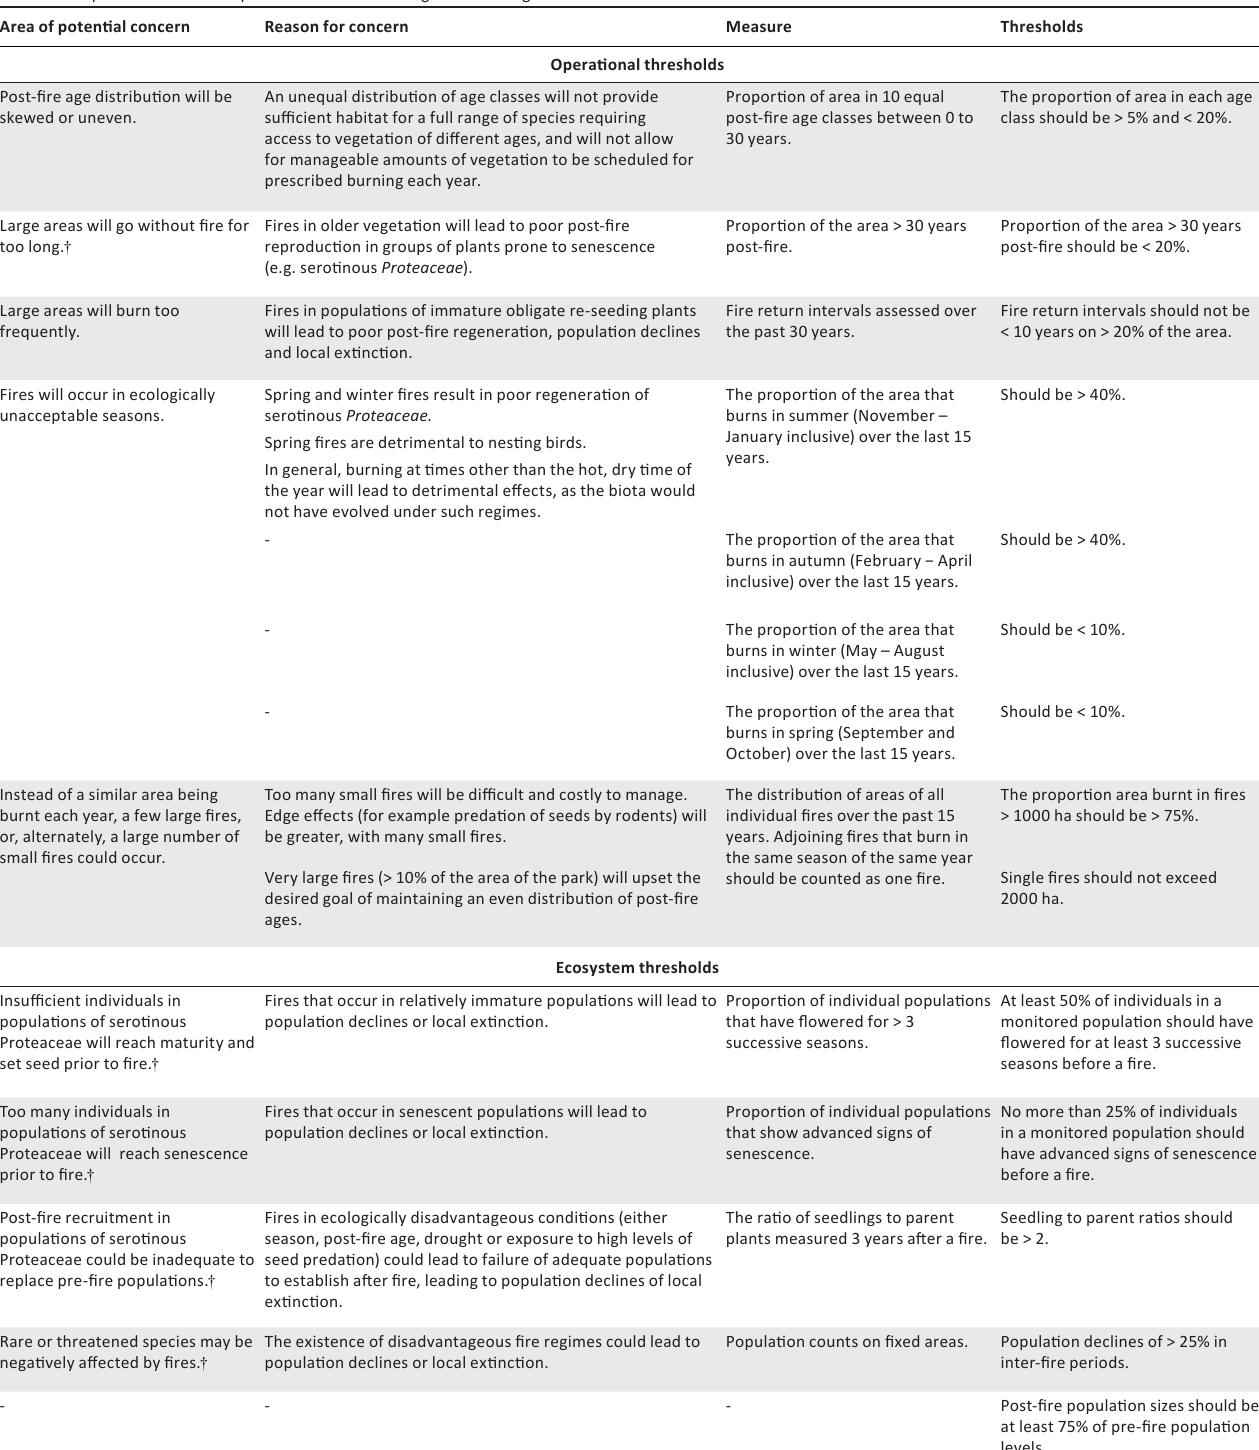
TABLE 2: Proposed thresholds of potential concern relating to fire management in the Table Mountain National Park. Area of potential concern Reason for